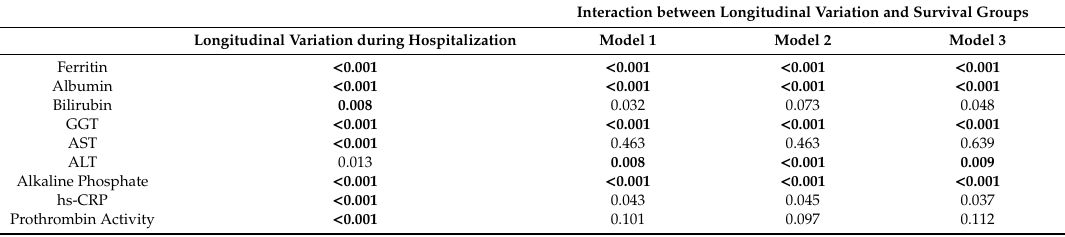
GGT—gamma-glutamyltransferase;